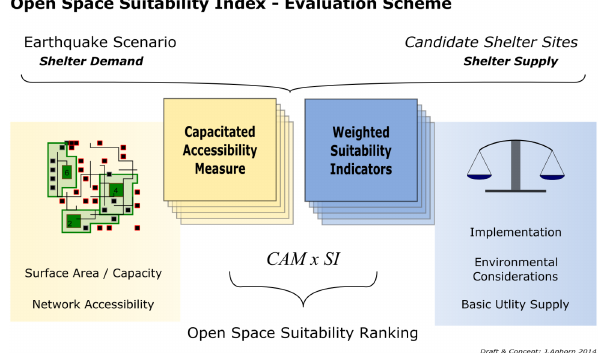
Figure 1. Open Space Suitability Index (OSSI) evaluation